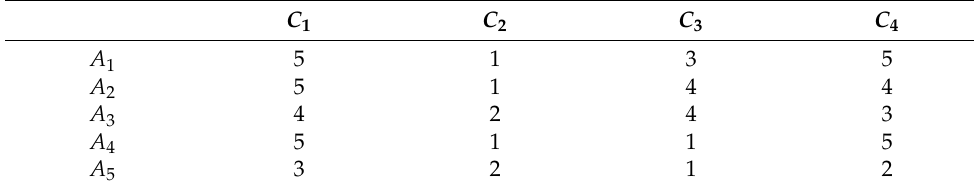
Table 5. The third of four selected initial decision-making matrices.